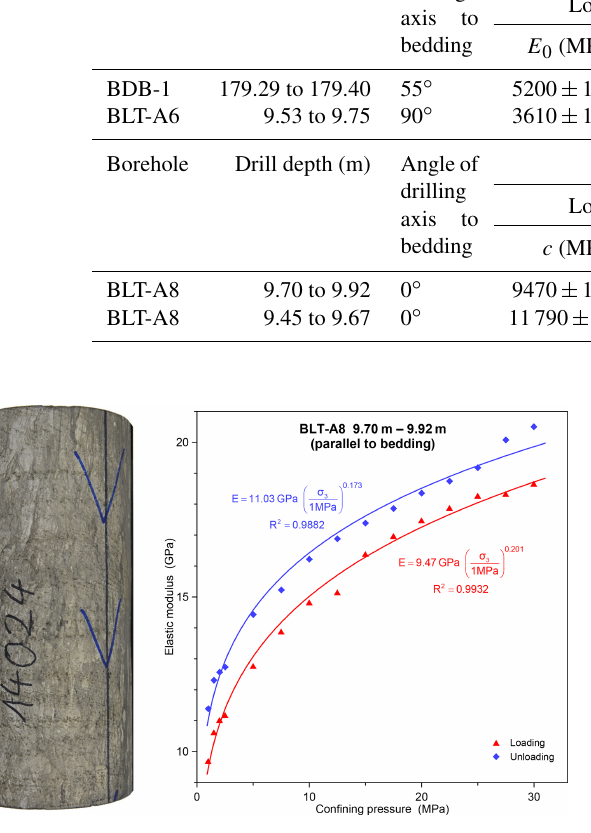
Figure 14. Sample from BLT-A8 borehole (9.70 to 9.92m) and dependency of elastic modulus on confining